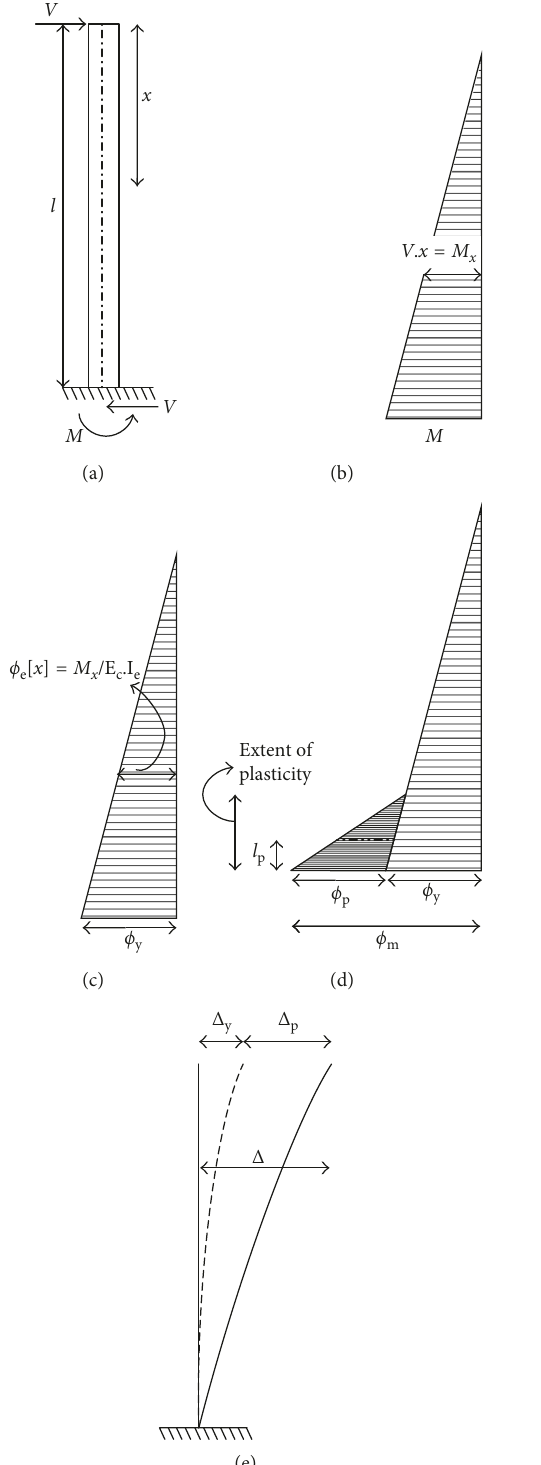
Figure 11: Momentcurvatureanddeflectionrelationshipsforprismatic reinforced concrete. (a) Free body diagram of column; (b) moment; (c) yield curvatures; (d) curvature at maximum; (e)